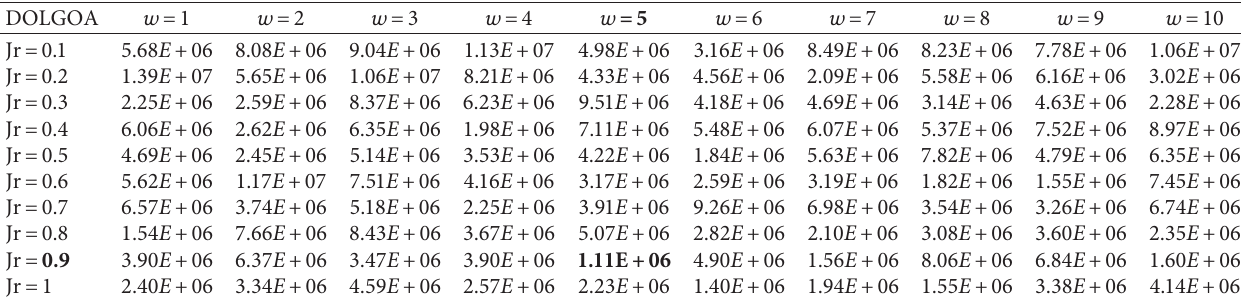
Table 3: The analysis of w and Jr.